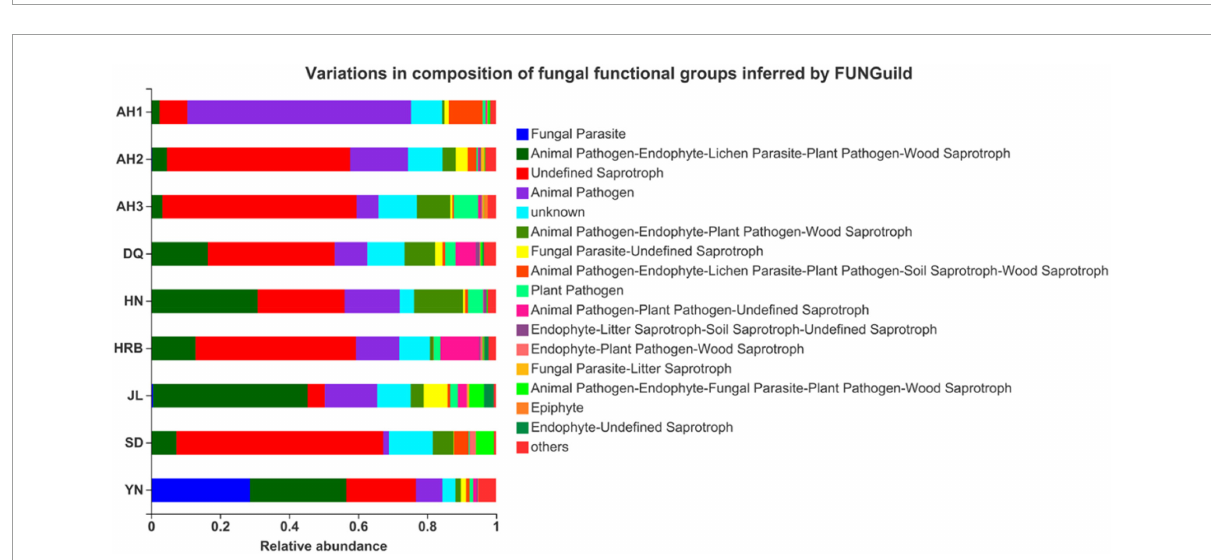
FIGURE9 Comparison of predicted fungal functional groups among the nine geographic populations of the hemp flea beetle P. attenuata in China by